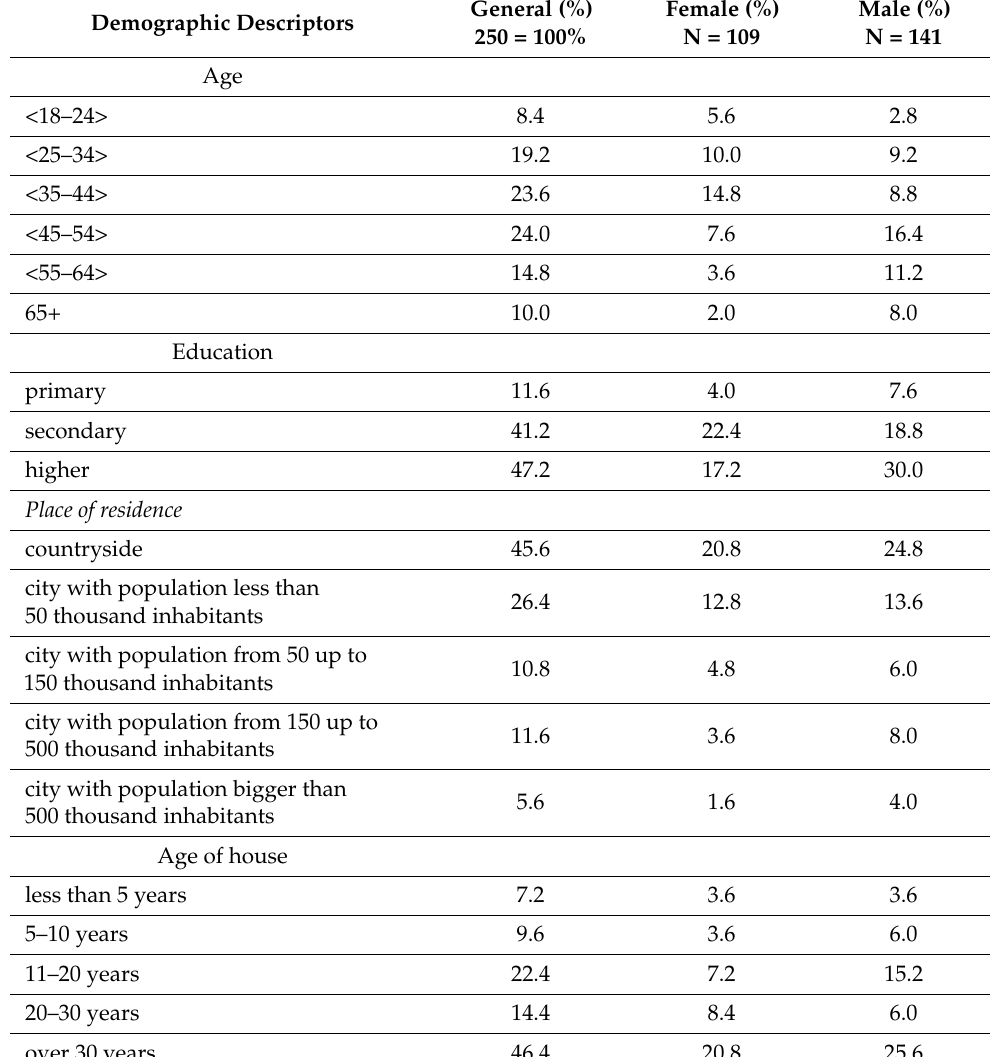
Table 1. Demographic description of